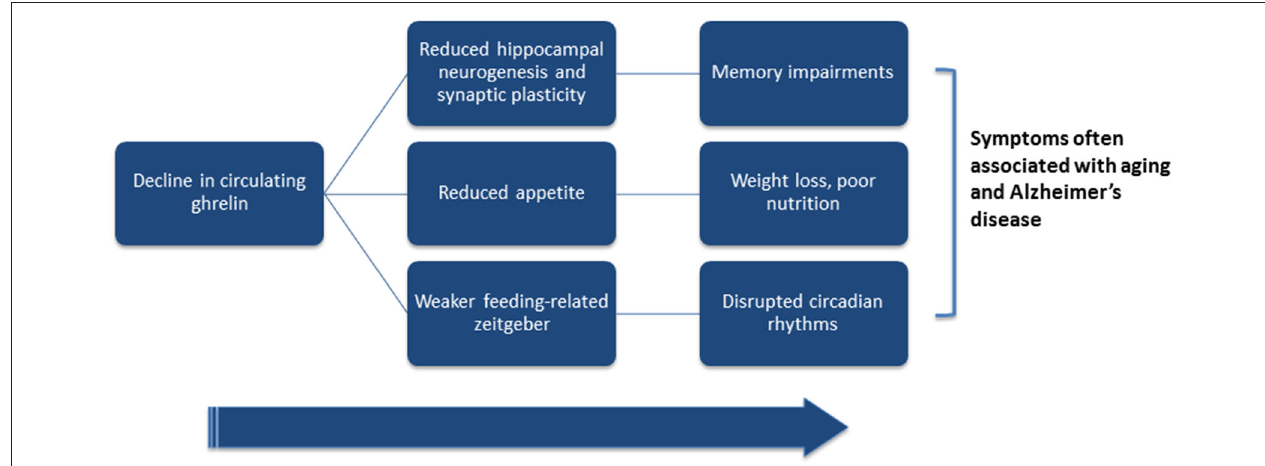
neurogenesis, and contribute to the cognitive deficits associated with old-age and AD. Lower circulating levels of ghrelin may also reduce hunger levels, and may partially underlie the weight loss associated with older age and AD. Finally, if ghrelin acts to enhance feeding-related zeitgebers, then reductions in circulating ghrelin could dampen food-entrained oscillators and disrupt circadian